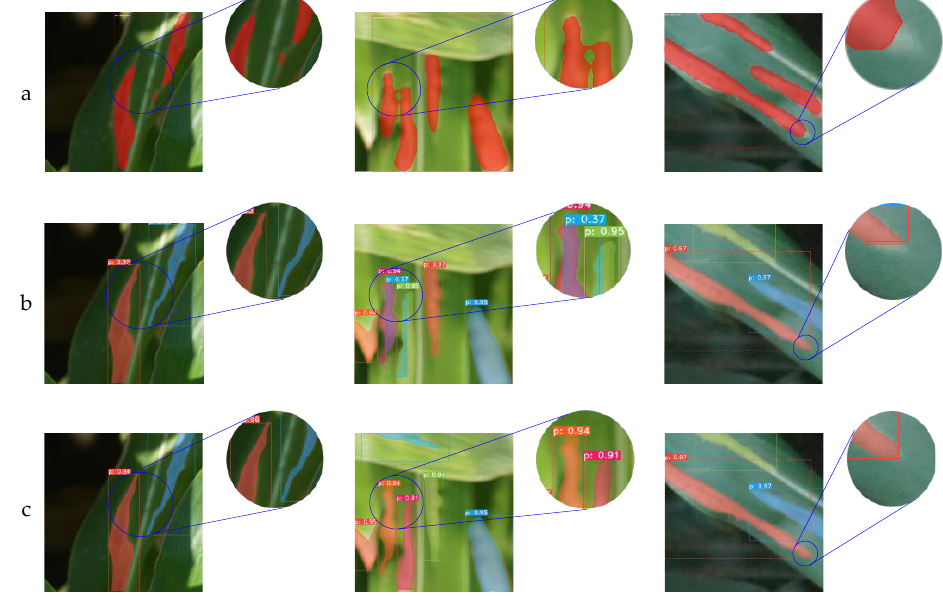
Figure 11. Examples of lesion segmentation results for different methods. ( a ) Mask R-CNN, ( b ) YOLACT++, and ( c ) Attention YOLACT++ .